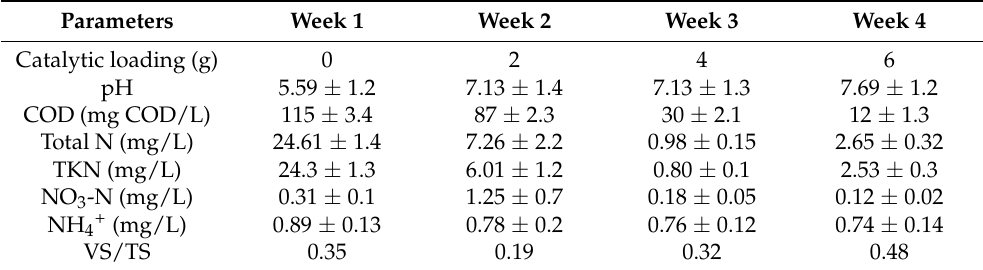
Table 1. A summary of results obtained for the weekly catalyst load of Fe-TiO 2 on organic contami- nants by using the biophotocatalytic system for four